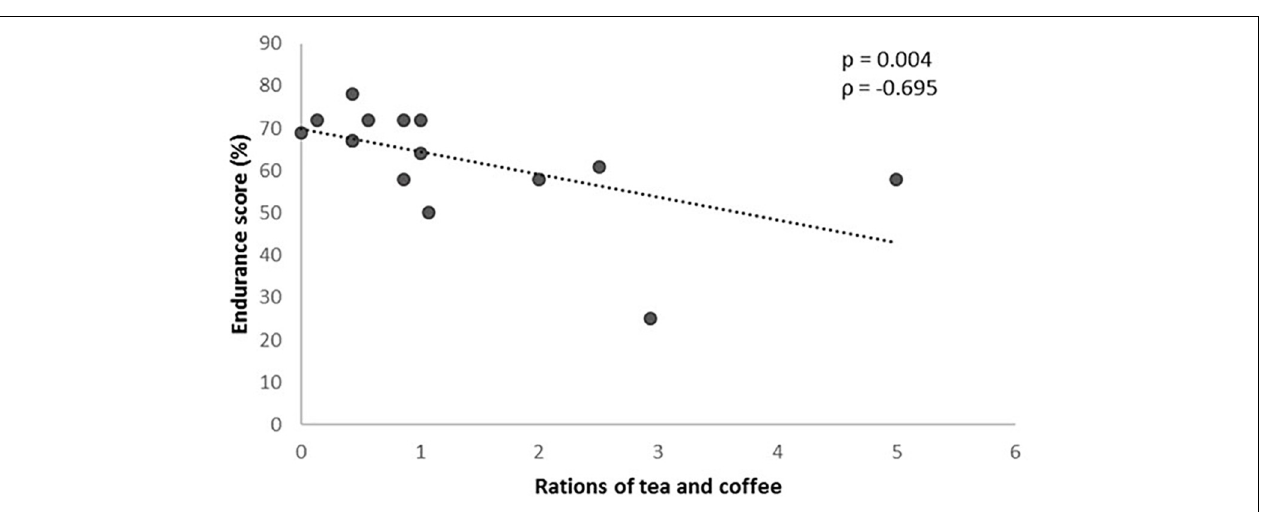
FIGURE 4 | Rations of tea and coffee consumed according to the genetic endurance prediction score